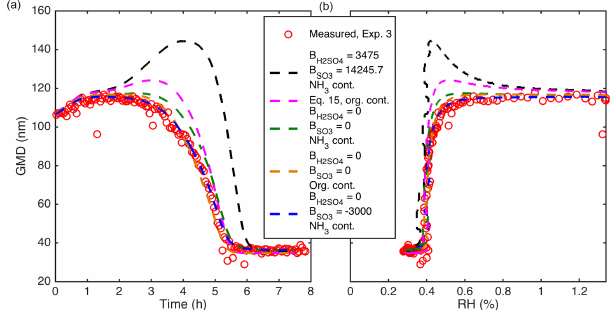
Figure 5. Measured and modelled GMD evolution as a function of (a) time and (b) RH for experiment 3 performed at a temper- ature range from 268 to 293K. The modelled particles are com- posed of S(VI), H 2 O and either NH 3 or non-volatile, non-water- soluble organics as a particle-phase contaminant. The simulations correspond to Case 1 (the H 2 SO 4 activity is calculated with use of Eq. (15) and the tabulated H 2 SO 4 chemical potentials from Giauque et al., 1960; see Supplement, Table S1, simulation 28) and Case = 2.40 × 10 9 molkg − 1 and x K = 1.43 × 10 10 at 2a, K H SO 3 2 SO 4 T = 288.8K (see Supplement, Table S1, simulations 29, 33, 34 and 36). The pure-liquid saturation vapour pressures of H 2 SO 4 and SO 3 are calculated with Eq. (11) (Kulmala and Laaksonen, 1990; Noppel et al., 2002) and Eq. (12) (Nickless, 1968),